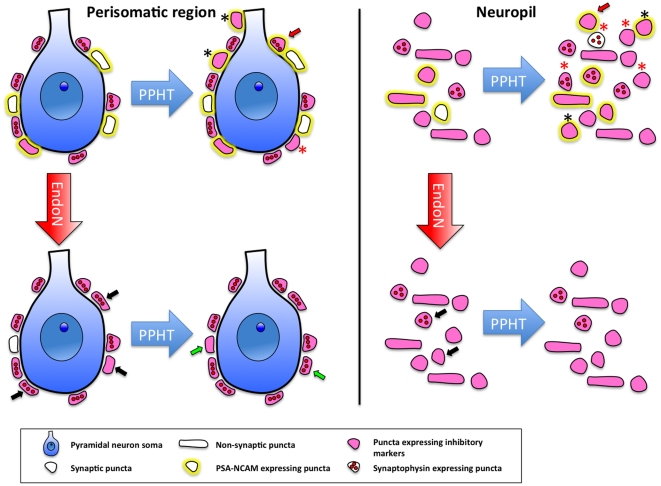
Schematic drawing of the hypothetic effects of PPHT and/or Endo-N administration in the perisomatic region of pyramidal neurons and in the neuropil of the medial prefrontal cortex.
Perisomatic region: PPHT induces the appearance of new inhibitory contacts: some of them express PSA-NCAM (black asterisks), but some others may have already lost PSA-NCAM expression (red asterisks). Expression of PSA-NCAM may also be induced in preexisting inhibitory contacts (red arrow). It is possible that some of these PSA-NCAM expressing puncta were not functional synapses and this may be why we do not detect changes in the number of synaptophysin expressing puncta and there are decreases in the percentage of parvalbumin positive puncta that co-express synaptophysin. Endo-N depletes PSA-NCAM from the perisomatic region and promotes the maturation of contacts that previously expressed PSA-NCAM, inducing the expression of inhibitory markers (parvalbumin/GAD) and/or synaptophysin (black arrows), leading also to an increase of the percentage of parvalbumin puncta co-expressing synaptophysin. When PPHT is administered after Endo-N, most puncta remain stable, although some of them may continue with the maturation process initiated by PSA depletion and/or promoted by PPHT (green arrows). Neuropil: Note that the proportion of PSA-NCAM expressing puncta is more reduced than in the perisomatic region of pyramidal neurons and that many of these puncta do not correspond to synaptic boutons. PPHT induces the appearance of inhibitory puncta; some of them express PSA-NCAM (black asterisks) and some of them may have already lost its expression (red asterisks). Some of these newly generated structures may have matured faster than in the perisomatic region and have started to express synaptophysin. Endo-N administration may have little impact on neuropil because of the low proportion of PSA-NCAM expressing puncta in this region and because the nature of these puncta is different: most perisomatic puncta should correspond to presynaptic boutons contacting the pyramidal cell body, while in the neuropil many of these structures correspond to dendritic and axonal processes and not to synaptic contacts. The expression of inhibitory markers (parvalbumin/GAD) and/or synaptophysin would only be induced in some scarce puncta (black arrows). The administration of PPHT after Endo-N does not produce any effect, because the presence of PSA-NCAM may be absolutely necessary to induce the changes mediated by PPHT in this region.